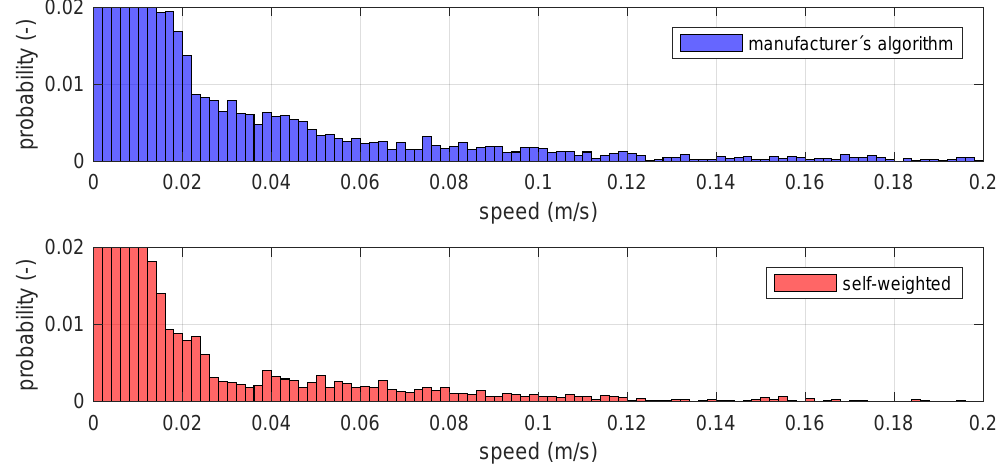
Figure 11. Speed distribution along the test trajectory